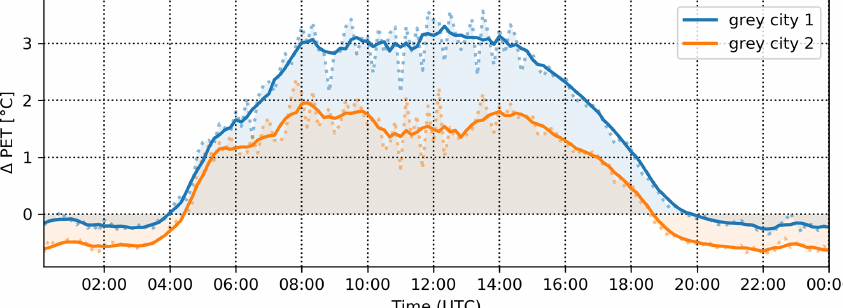
Figure 11. Domain-averaged differences in PET for grey-city scenarios SB10 (blue) and SB11 (orange). Dotted lines: 10min values; solid lines: 1h moving